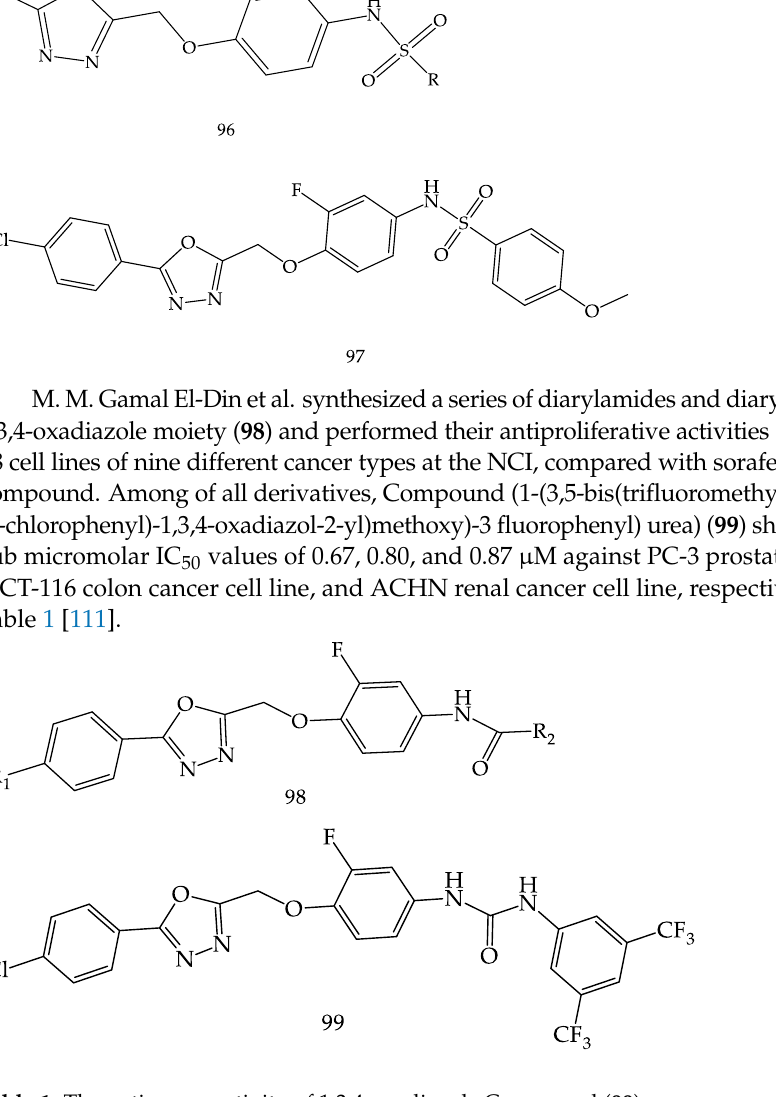
Table 1. The anticancer activity of 1,3,4-oxadiazole Compound (99). Cell Line